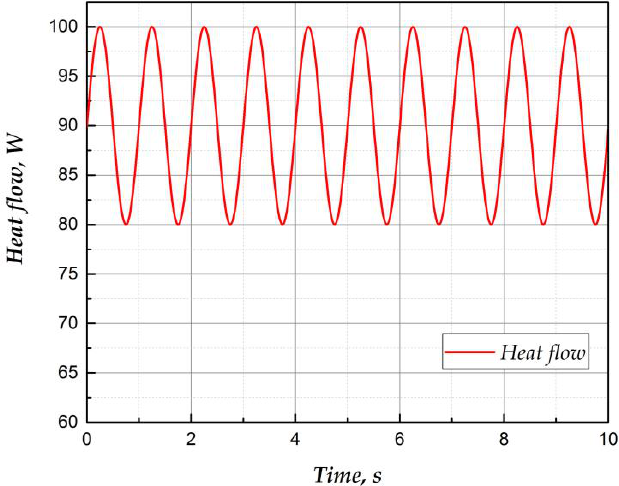
Figure 9. The input of heat flow.